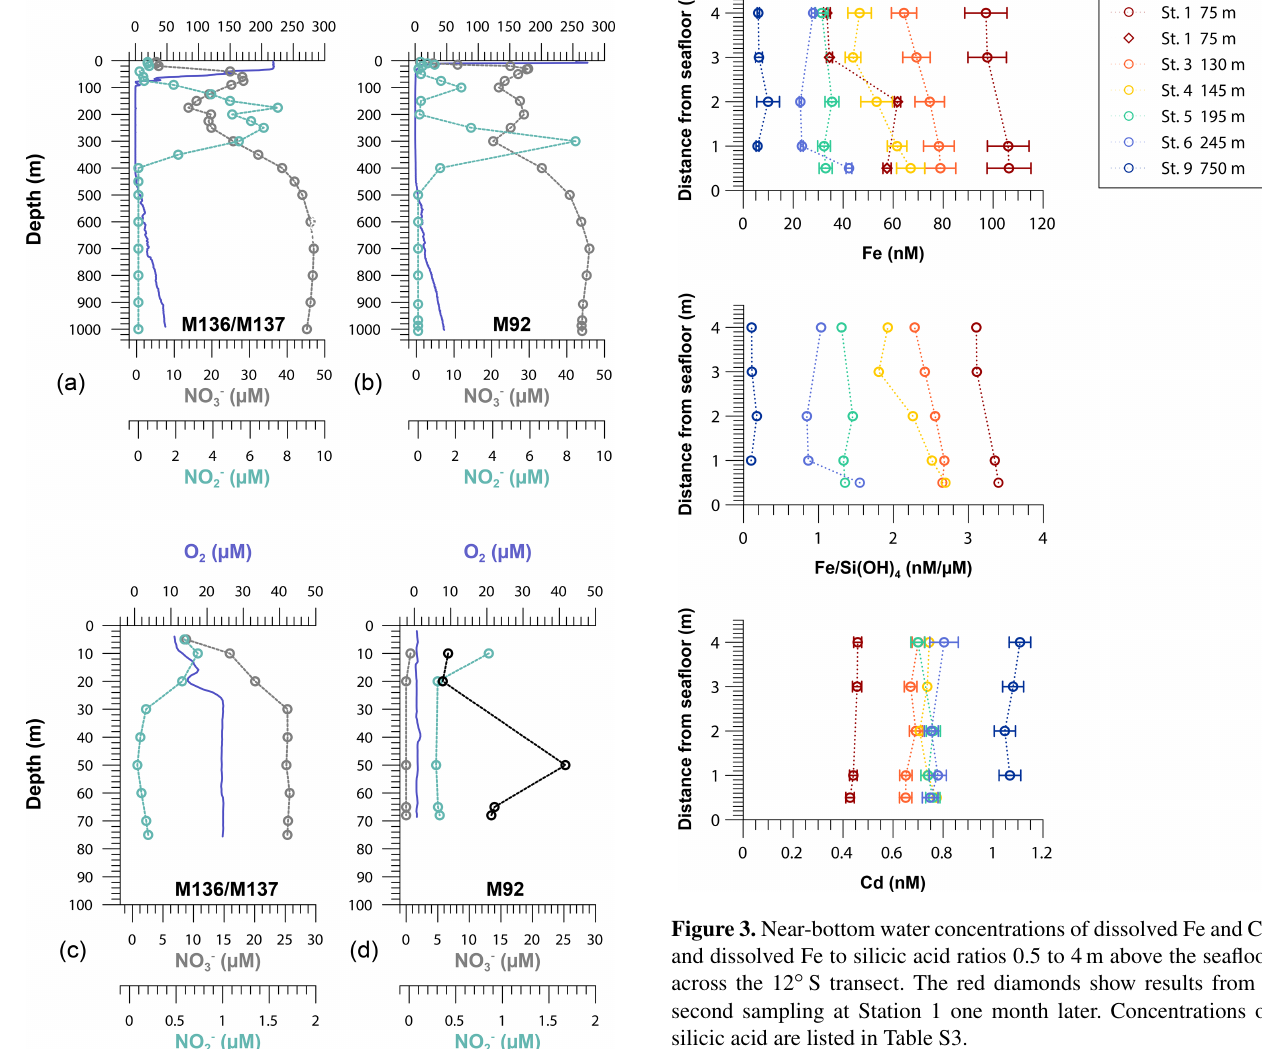
), nitrite (NO − ) and hydro- 3 2